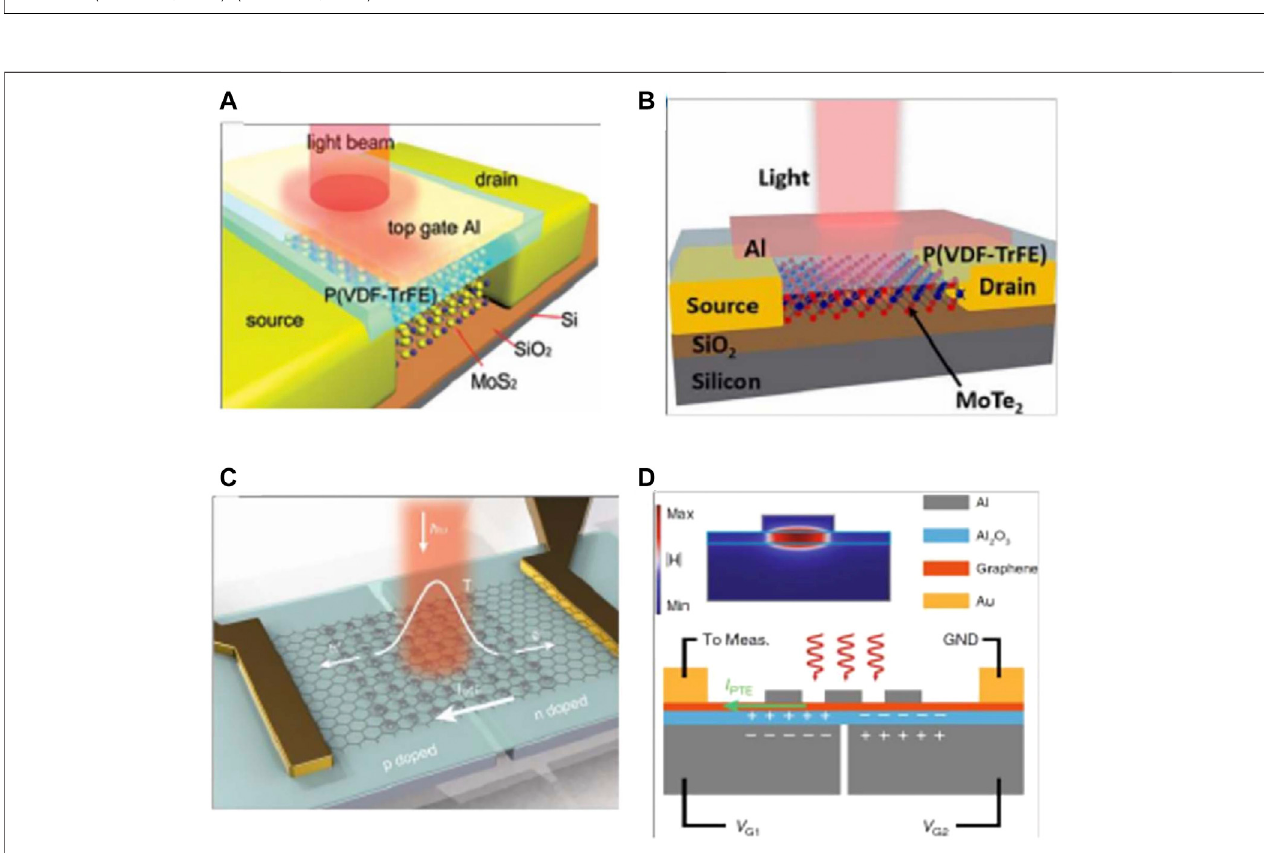
Frontiers in Chemistry |